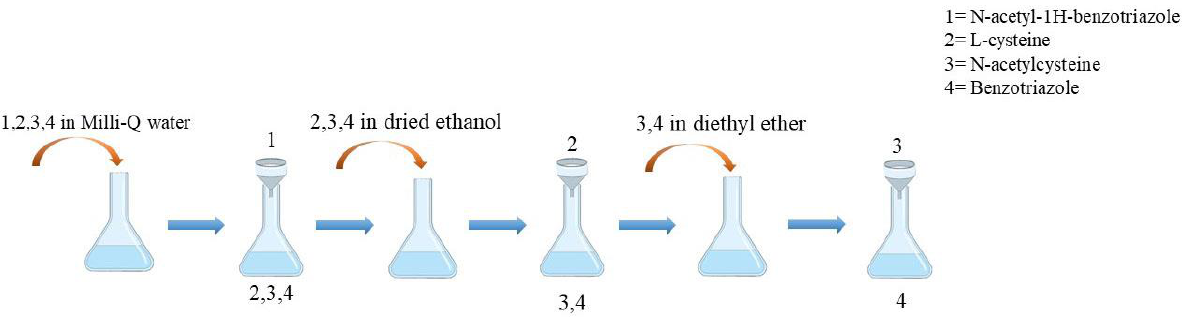
Figure 1. The schematic chemical synthesis of N -acetylcysteine.